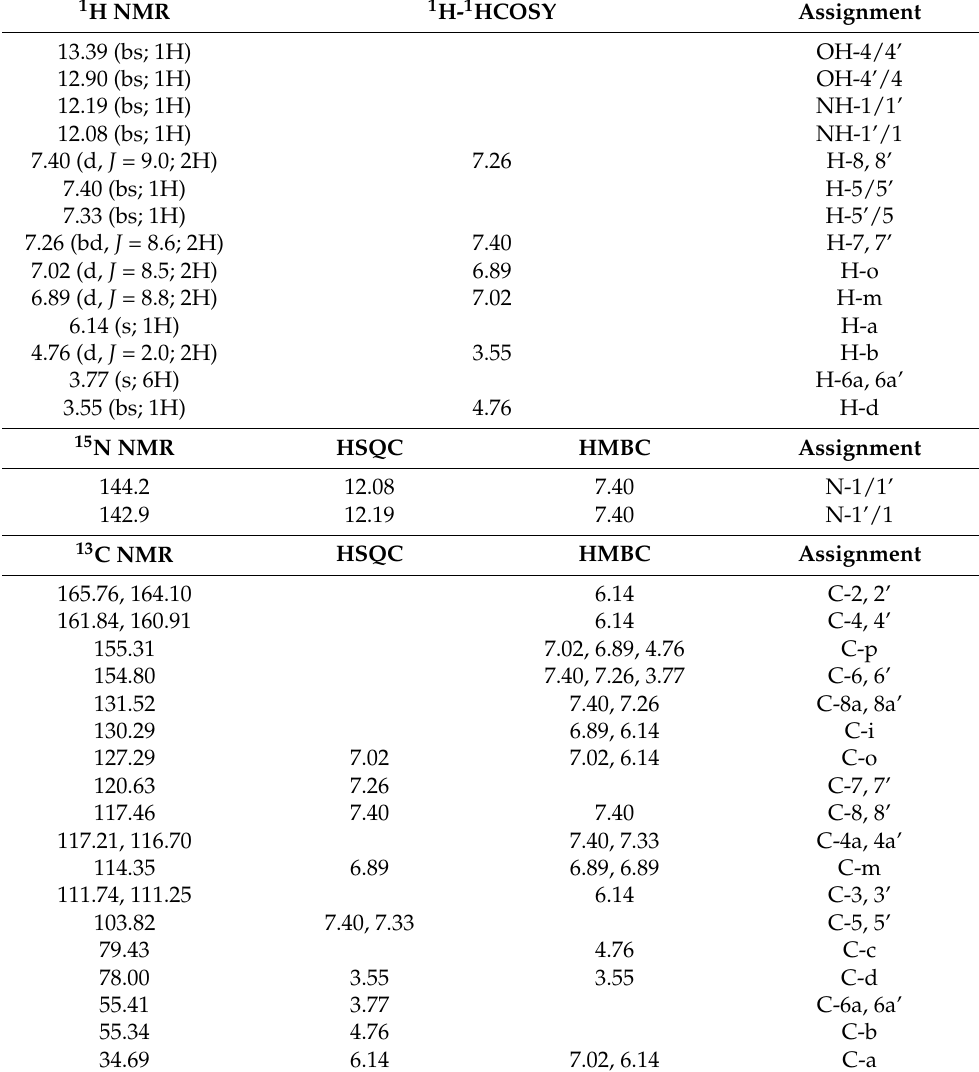
Table 1. Spectrum data for compound 4b